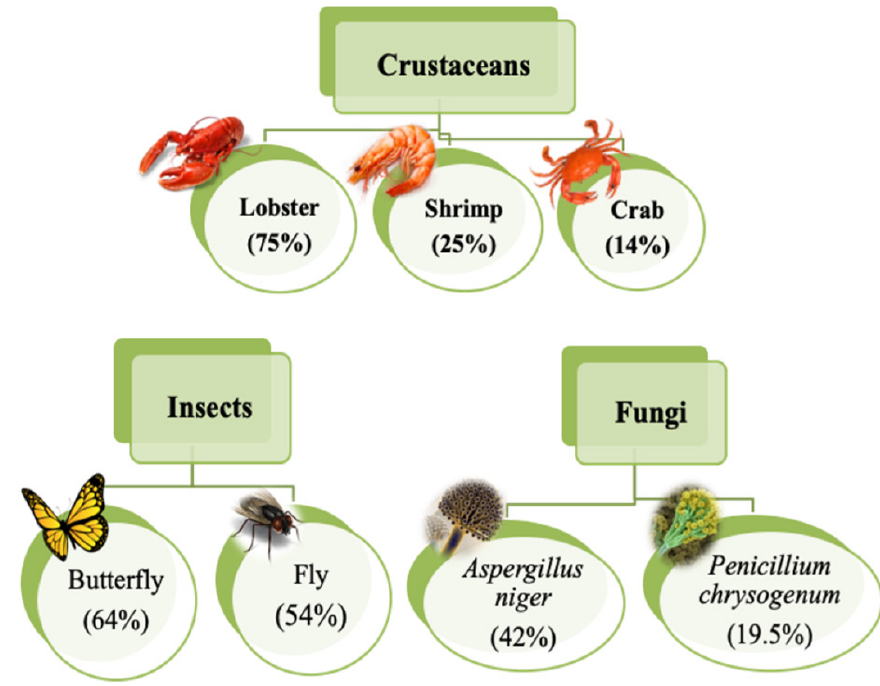
Figure 3. Different sources of chitin (taken from [13] under Creative Commons License).